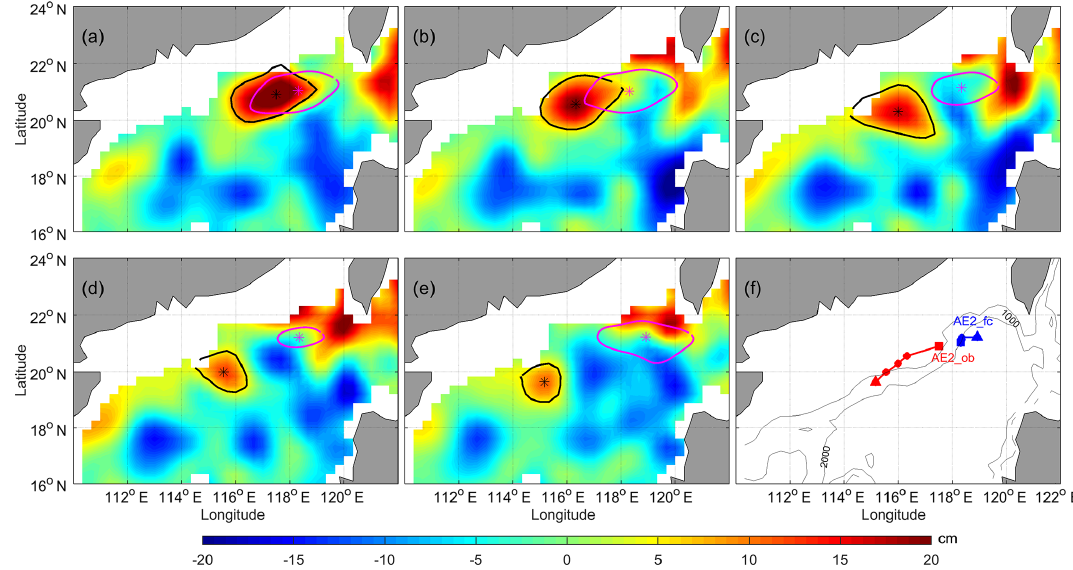
Figure 13. Same as Fig. 11, but for Exp6 and AE2; the experiment period is the 29 February to the 30 March 2004.